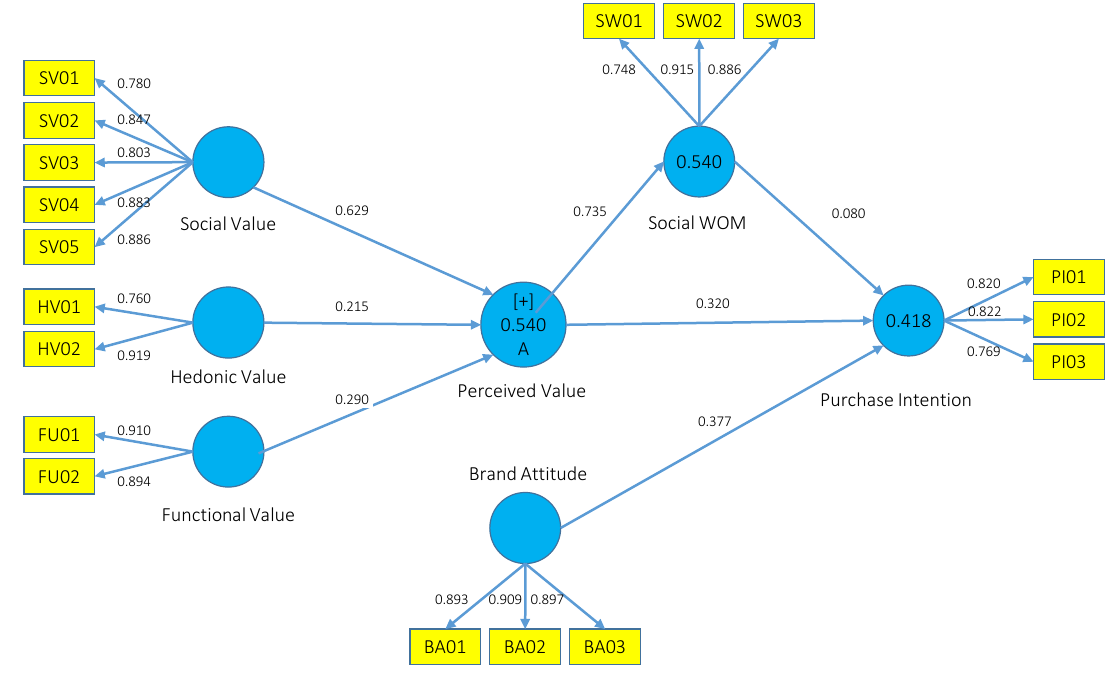
Figure 2. SEM analysis result for hypothesis